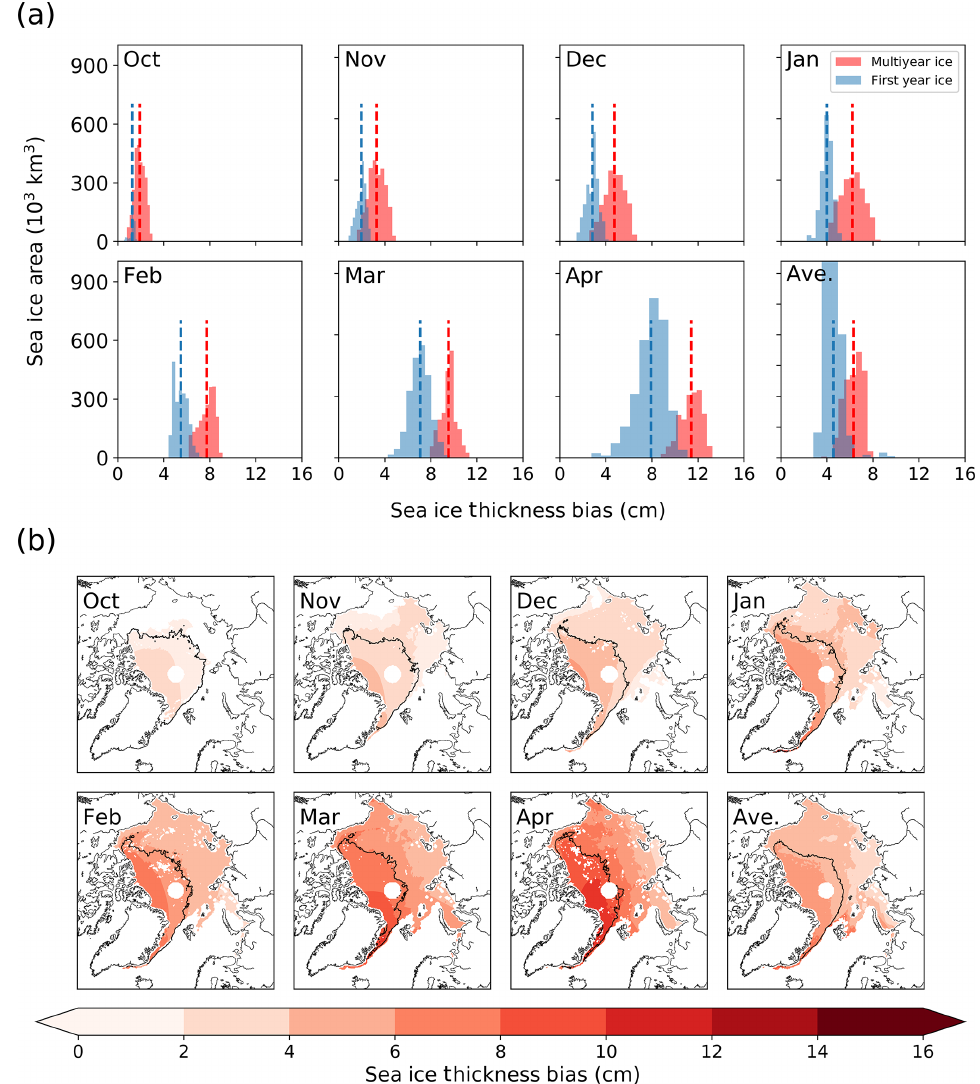
Figure 2. Monthly biases in sea ice thickness due to the effect of ignoring snow densification in calculating propagation correction. (a) Spa- tially averaged histograms indicating the area of ice subjected to a given bias. Data separated into pixels that feature MYI for that month in more or less than 50% of the years of 2010–2018. Pixels that typically feature MYI experience greater bias in all months, largely due to halved W99 snow depths over FYI. (b) Sea ice thickness bias introduced by use of a static snow density in the calculation of the propagation correction. Pixels are only displayed where sea ice type is known in all years 2010–2018, so bias is not displayed in some areas of ambiguous ice type. The black line indicates the region where MYI is present in over 50% of